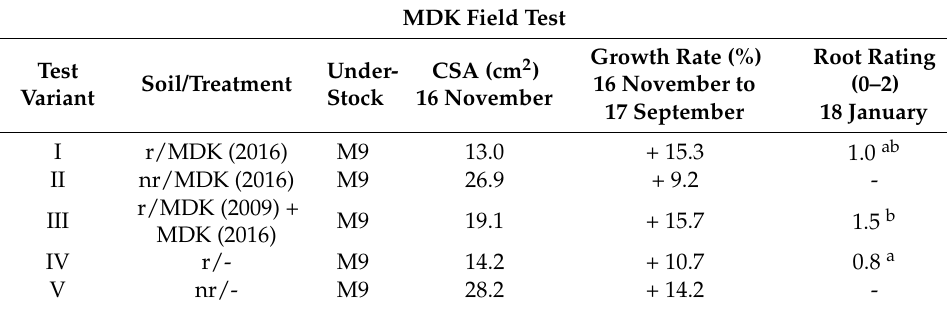
Table 8. MDK Field Test-effect of MDK on tree